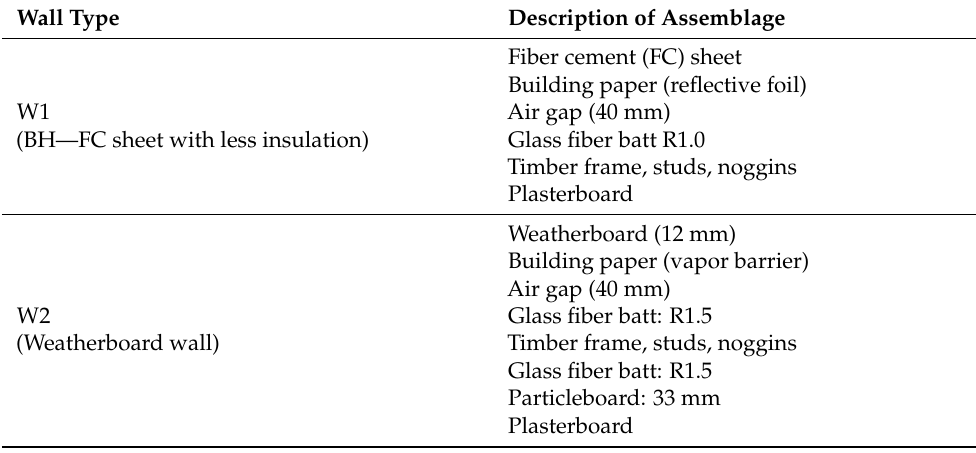
Table 5. Description of different wall